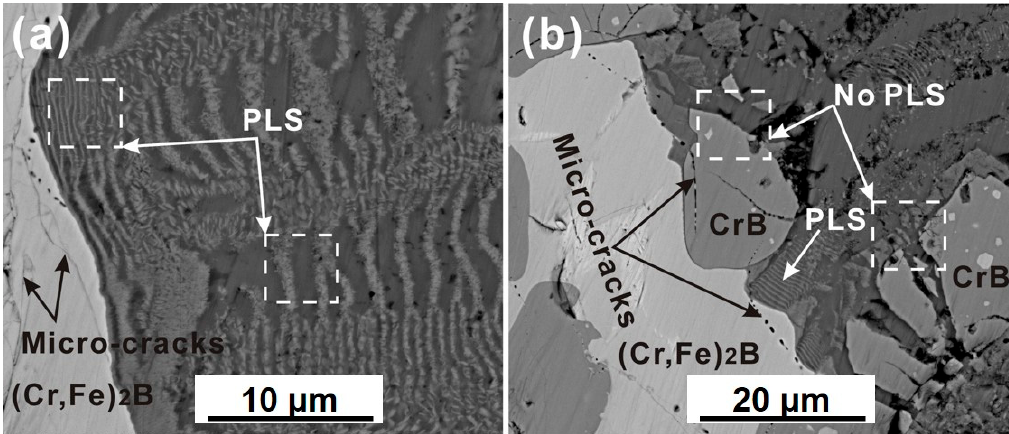
Figure 4. The cross-sectional morphology of the Fe-Cr-B alloy in liquid Al at 750 °C for 8 h. ( a ) The enlarged view of interface morphology at the (Cr, Fe) 2 B/Al interface. ( b ) The interface morphology observed at the CrB/Al interface.